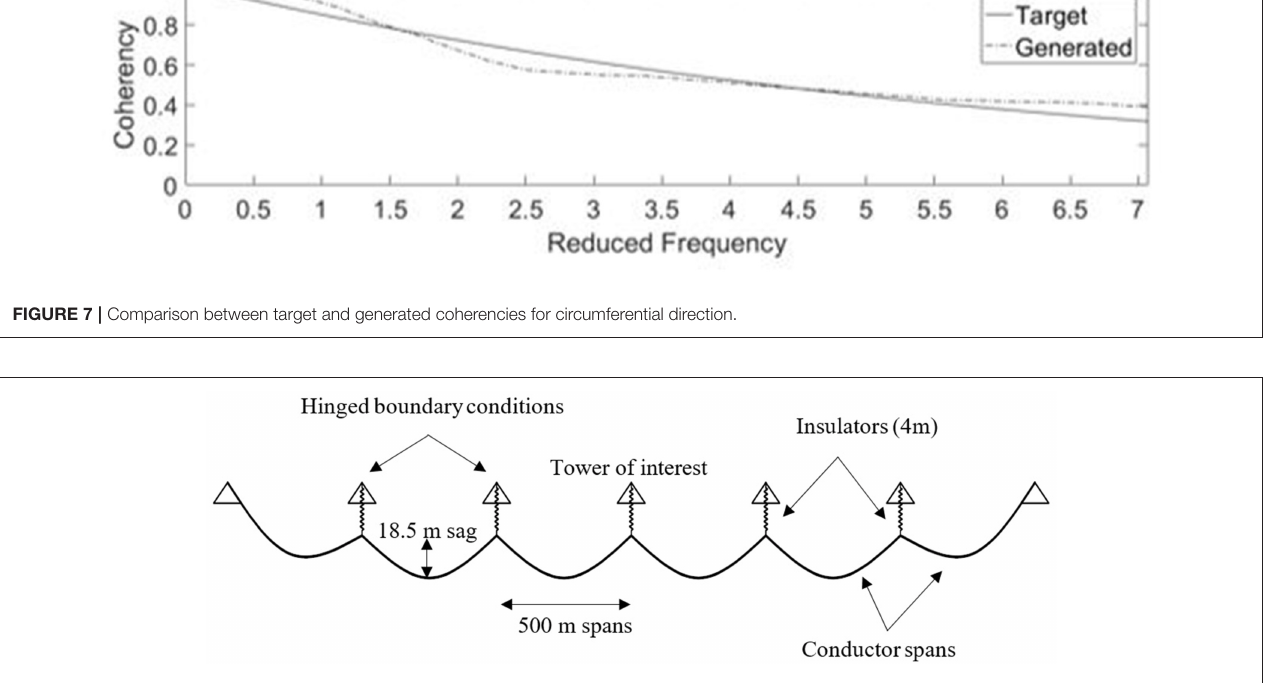
FIGURE 8 | Schematic of analyzed structure